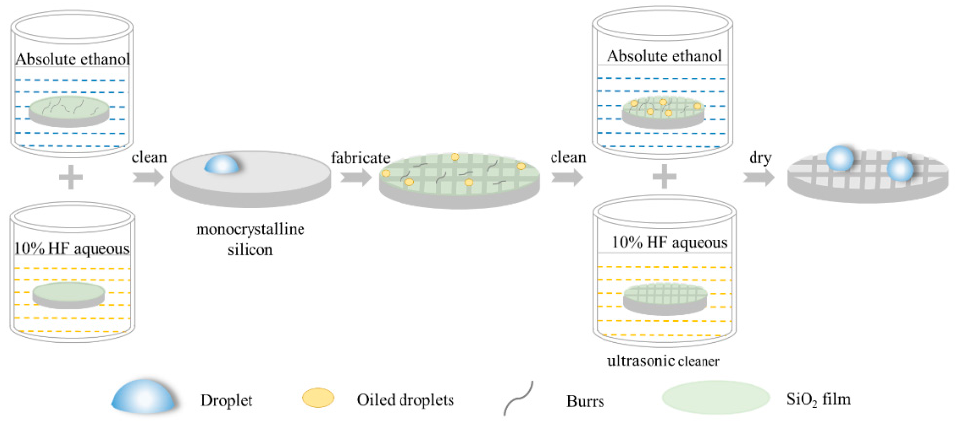
Figure 3. The processing flow chart for monocrystalline silicon.